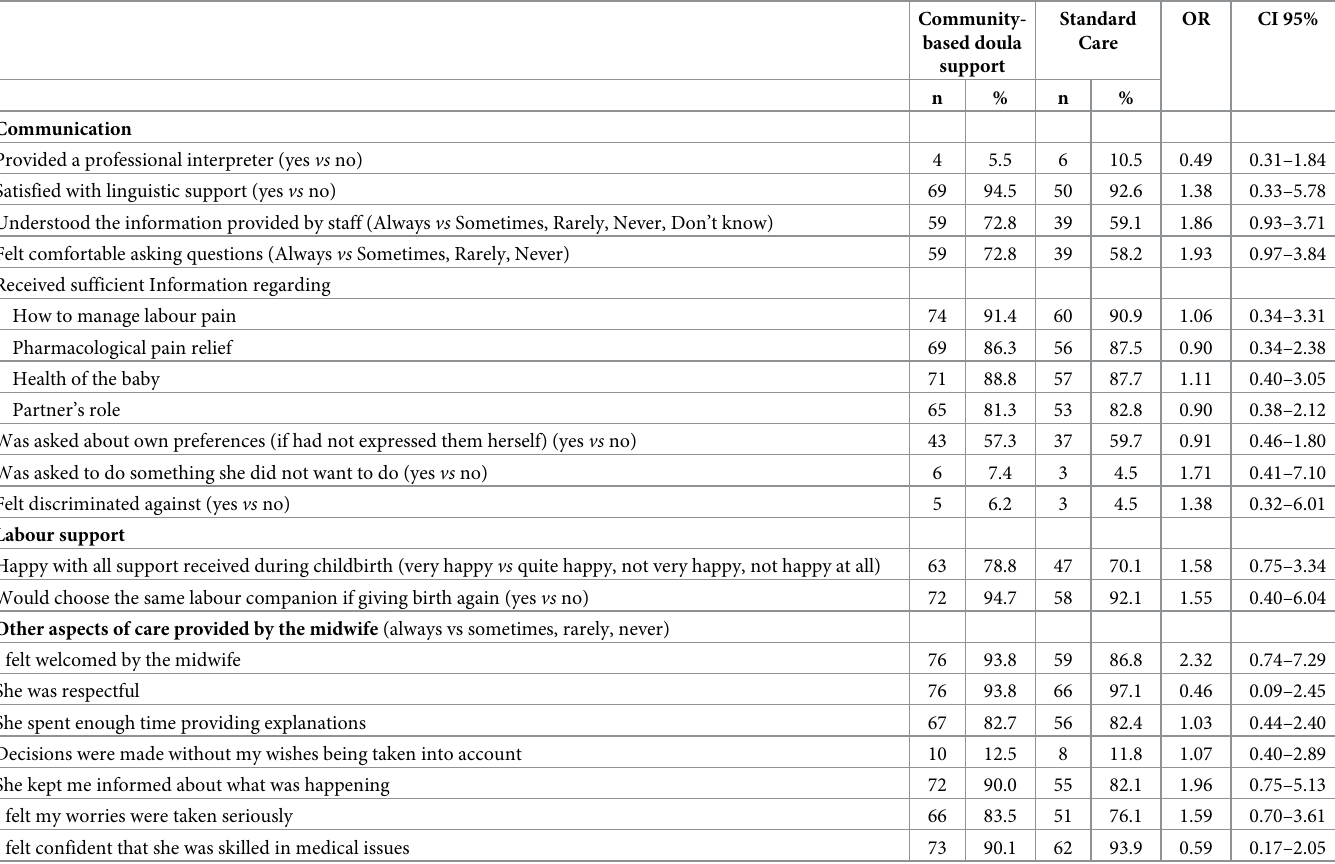
Table 3. Women’s assessments of communication, support and other aspects of care in relation to